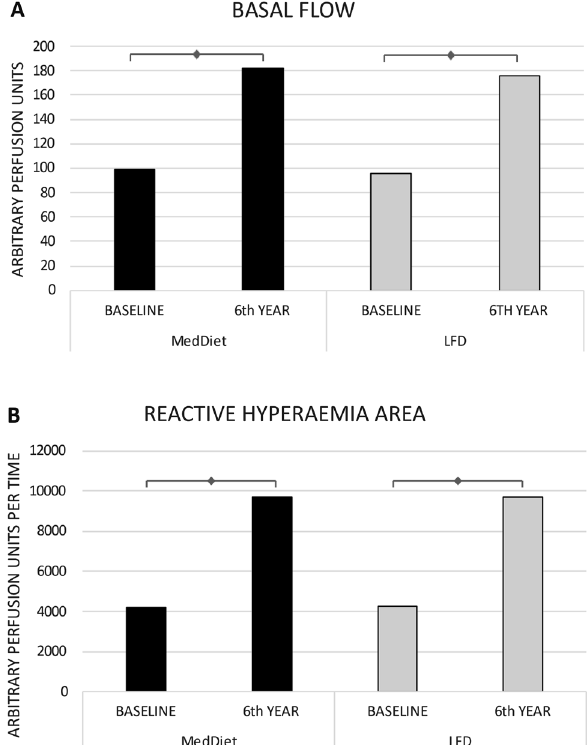
Figure 2. LASER DOPPLER FLOWMETRY (LDF). ( A ) Basal flow at baseline and after 6 years of consumption of MedDiet or LFD. ( B ) Reactive hyperaemia area at baseline and after 6 years of consumption of MedDiet or LFD. MedDiet, mediterranean diet; LFD, low fat diet. ◊ indicates significant differences ( p <